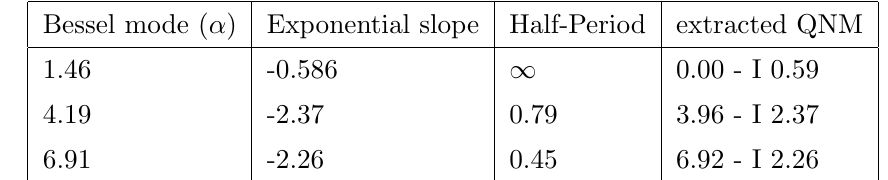
Table 1 . The parameters of the QNMs extracted from the late time analysis of the Bessel spectrum after the fast quench. The imaginary part of the QNM is measured from the exponential slope visible on the log-scale plot, (cid:12)gure 5, right panel. The real part is evaluated from the half period of oscillations Re [ ! ] = (cid:25) . All values in units of temperature T (cid:21)= 2